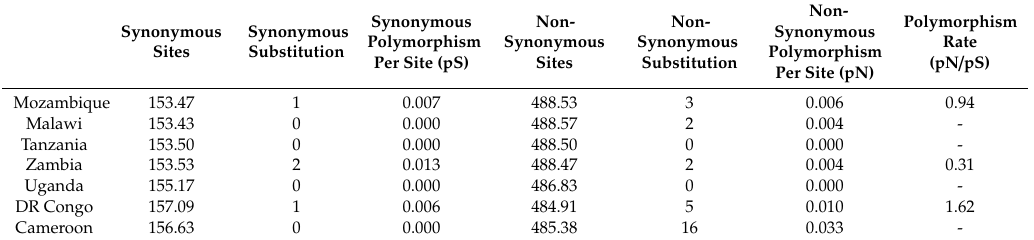
Table 2. Polymorphism rate measured by pN / pS ratios of the CYP6P9a locus for seven countries. Synonymous Sites